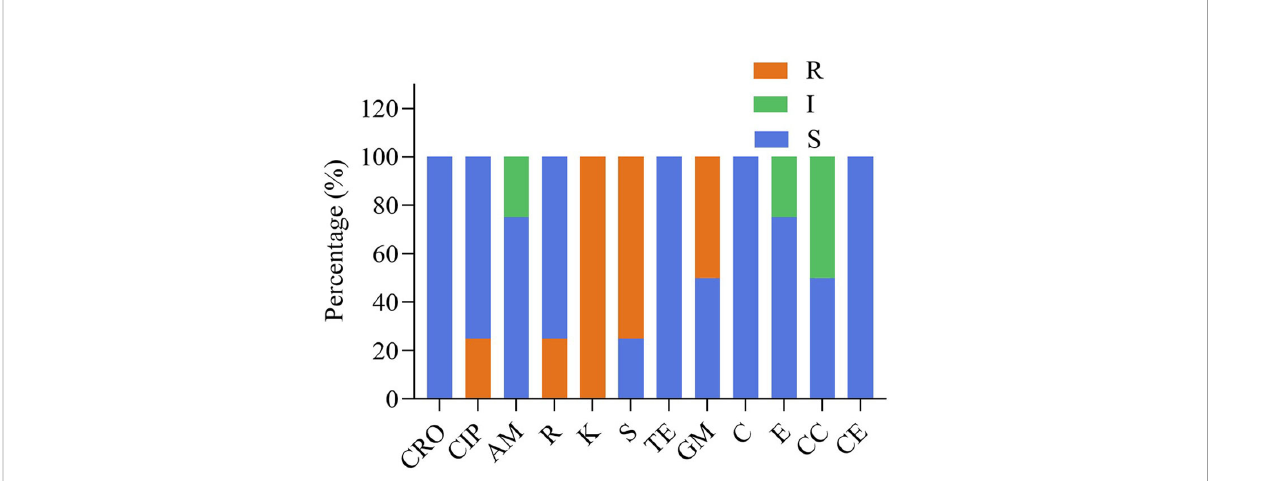
FIGURE 3 The antibiotic resistance of the LAB isolates against 12 tested antibiotics. Ceftriaxone (CRO), cipro fl oxacin (CIP), ampicillin (AM), rifampicin (R), kanamycin (K), streptomycin (S), tetracycline (TE), gentamicin (GM), chloramphenicol (C), erythromycin (E), clindamycin(CC), cephalothiophene (CE). The total number of LAB strains was taken as 100%. S, sensitive; I, intermediately resistant; R, resistant.